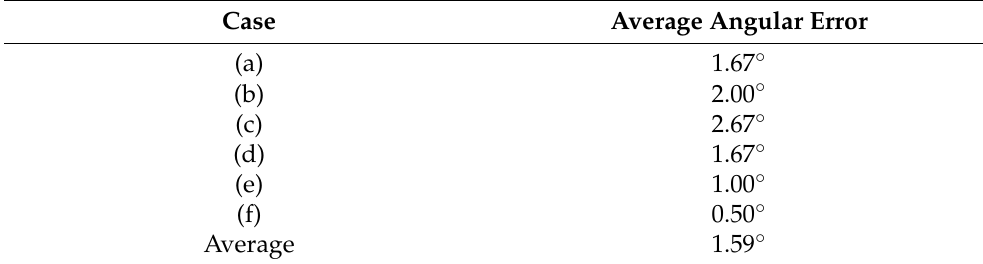
Table 8. Angular error to the 2D ground truth.